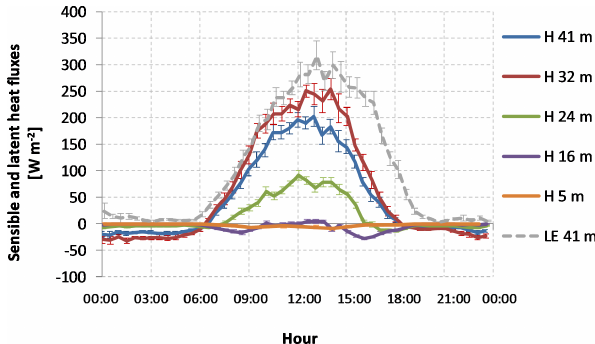
Figure 3. Average diel course of sensible heat fluxes at the five levels (41, 32, 24, 16 and 5m, thick lines) and latent heat flux at 41m (dashed line). Vertical bars represent the standard error of the